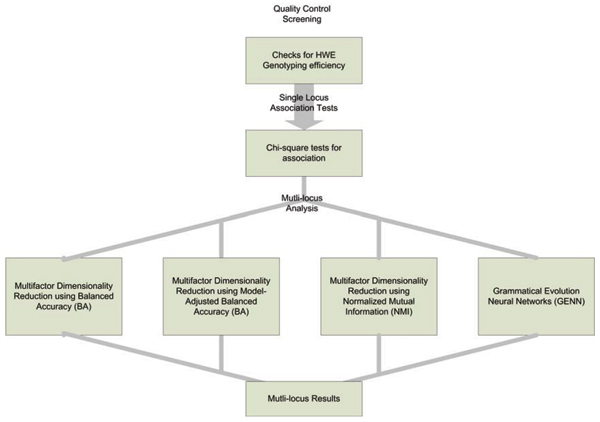
Data analysis plan.